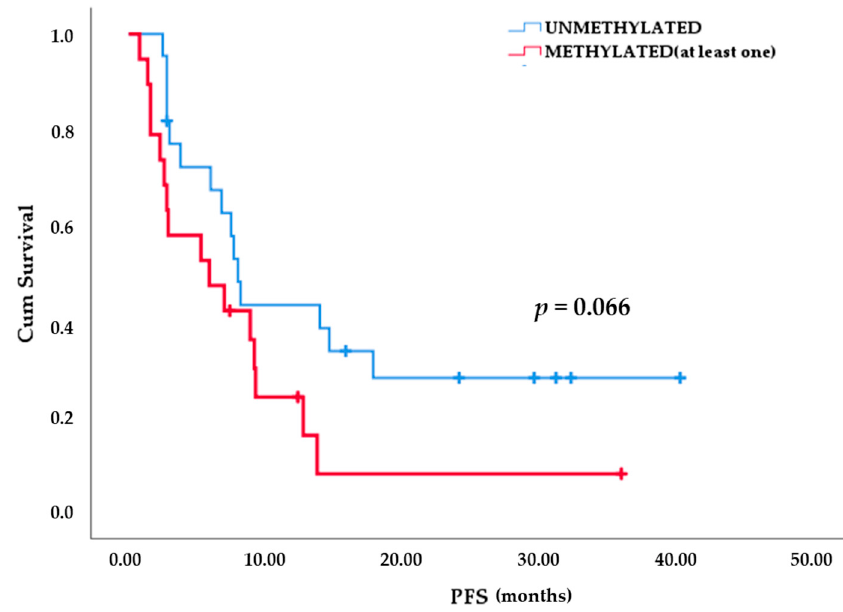
Figure 7. Kaplan-Meier analysis based on the methylation status for at least one marker in cfDNA and/or CTC at PD revealed a slight difference in terms of PFS.